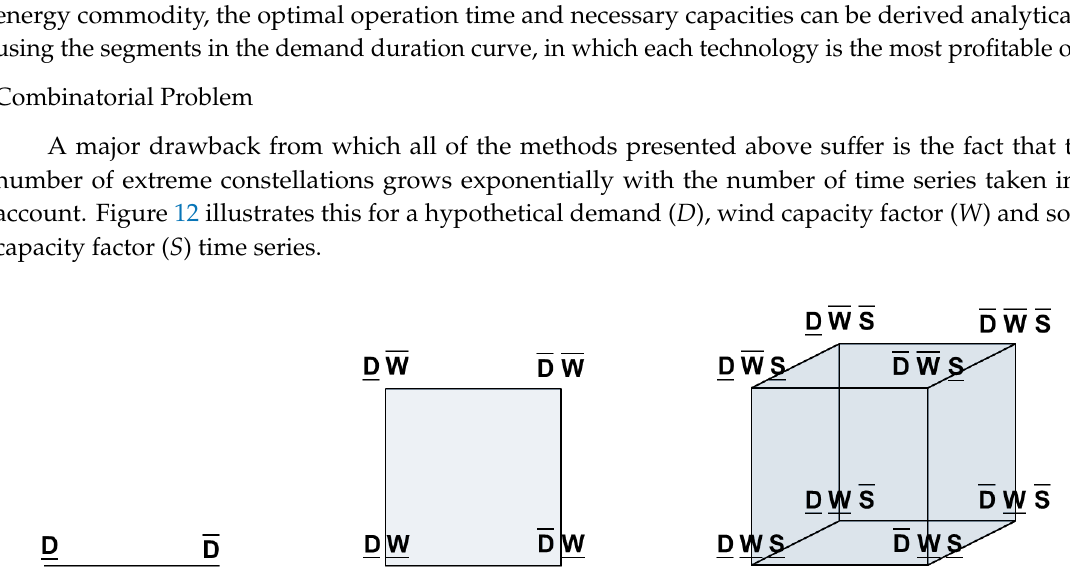
Figure 12. Impact of adding “shoulder values” as proposed by Frew et al. [182] as extreme values for a rising number of attributes.